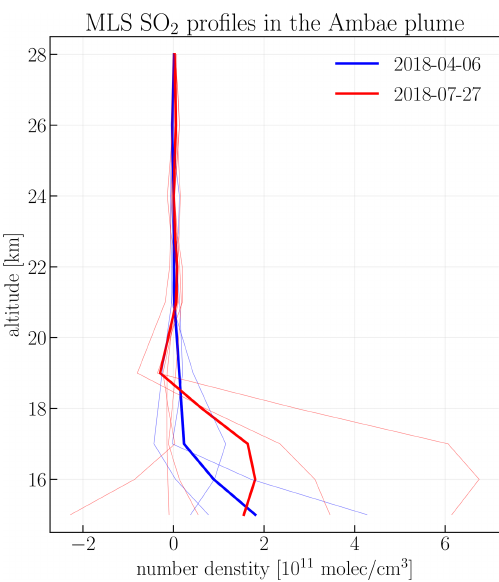
Figure A1. MLS SO 2 number density profiles in the Ambae plume on 6 April (blue lines) and on 27 July (red lines) 2018. The thick lines show mean profile, while thin lines depict individual measure- ments within the plume.